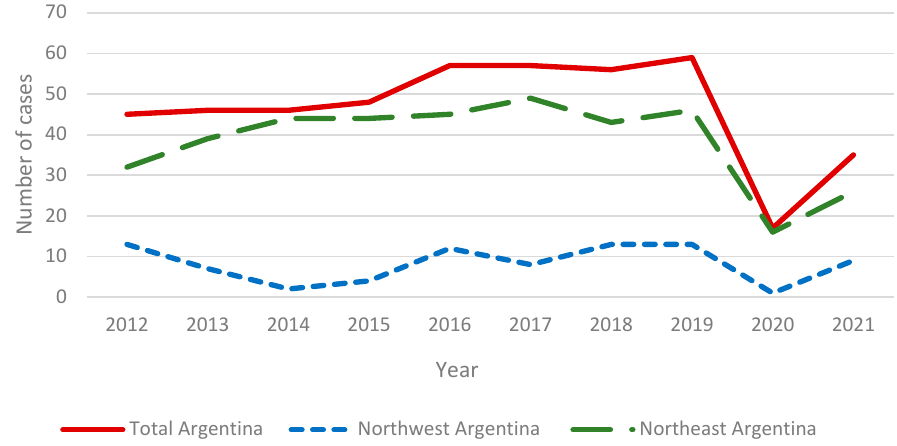
Figure 1. Temporal distribution of PCM cases in the period 2012–2021.